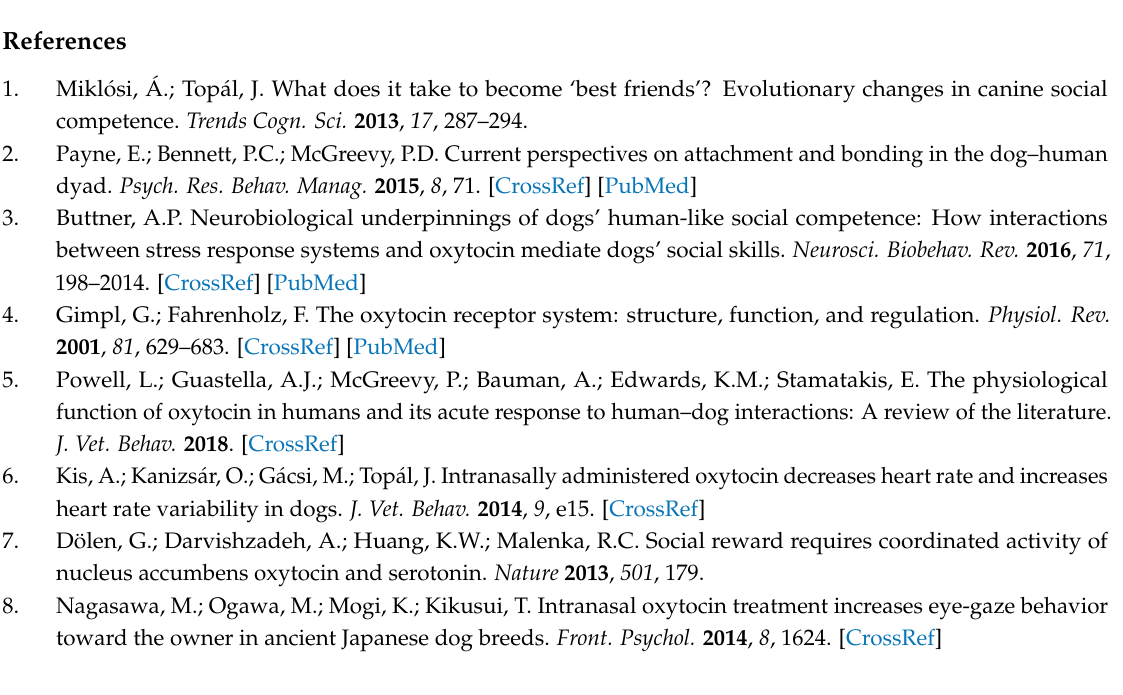
Table S1: Dog breeds ( n = 26); Table S2: Sub-group analyses of estimated mean change of urinary oxytocin concentration from pre- to post-condition by dog breed and